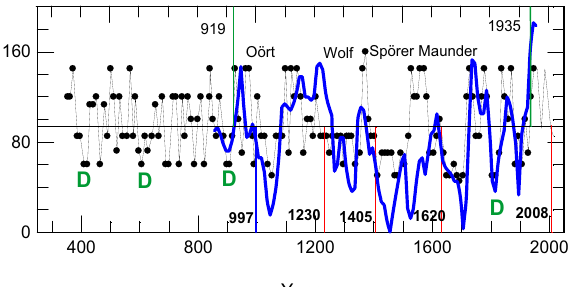
Fig. 10. The data series from Usoskin et al. (2003) (blue line) and Schove (1955) (points). The dashed line is the prediction of Schove for sunspot maxima #19 to #24. The vertical red lines indicate the transitions to Grand Minima, as determined by us (reviewed in De Jager & Duhau (2010) from the Nagovitsyn’s (2007) time series. The blue vertical line marks the transition to the Oort Grand Minimum. It was determined here in a similar way as the other transitions (vertical red lines). Letters D mark short (Dalton-type) minima. The black horizontal line is the Transition Point level and the two green vertical lines labelled 919 and 1935 mark the years in which the Hallstatt cycle passes through zero (cf. Fig. 9).